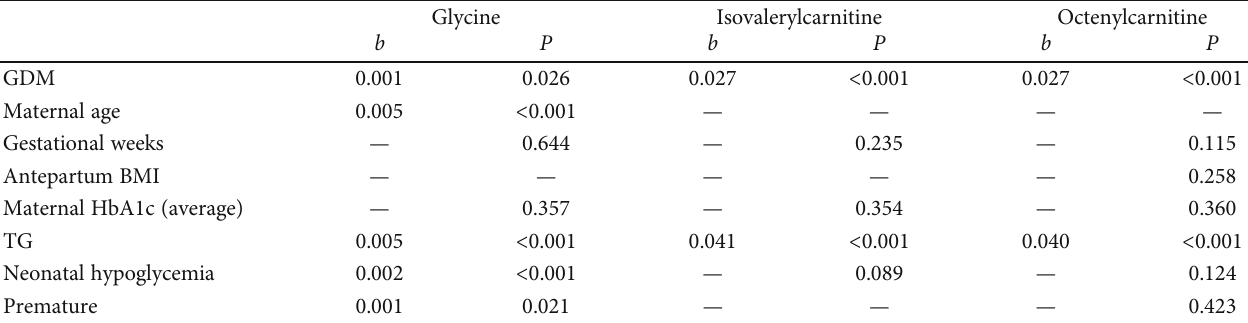
Table 6: The relationship between neonatal hypoglycemia and umbilical cord blood of amino acid and carnitine via ANCOVA analysis.